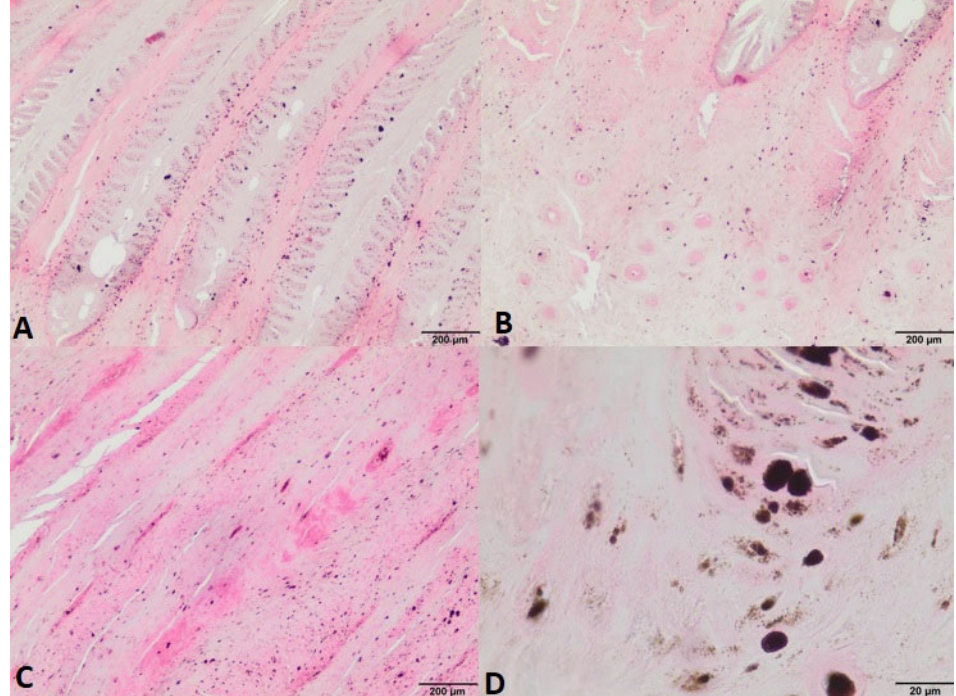
Figure 5. Photomicrograph of the hoof from the first histological examination with a diagnosis of keratoma, showing visible melanocytes, filled with melanin grains, showing no signs of cellular atypia or signs of proliferation. ( A )–( C ): HE staining, magn. 40×; ( D ): HE staining, magn. 400×.